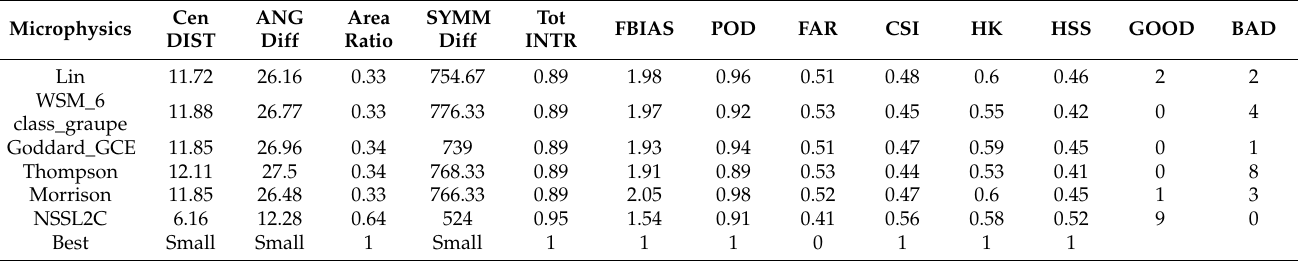
Table A2. Mode analysis using CMORPH satellite-based data.